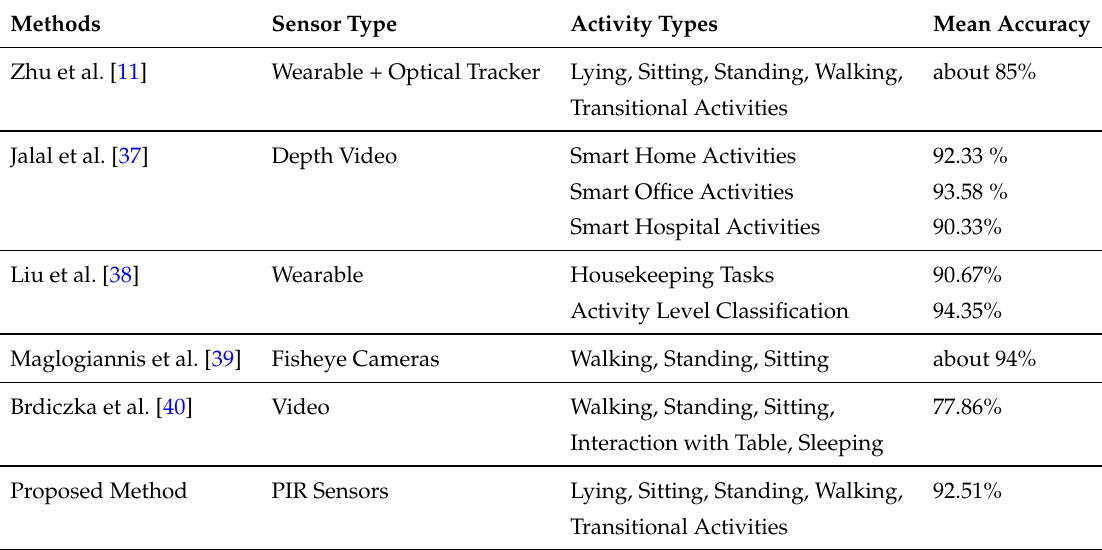
Table 6. Comparison of human activity recognition (HAR)